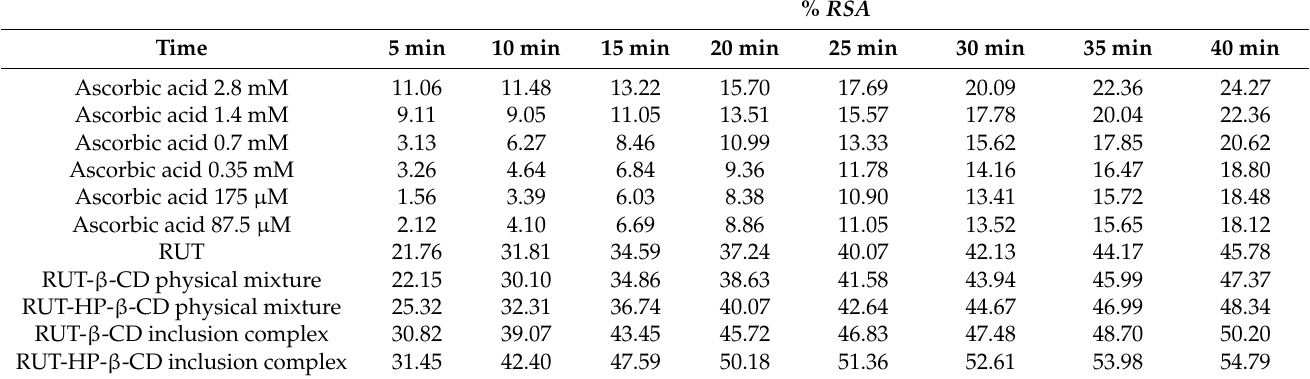
Table 3. DPPH radical scavenging activity.